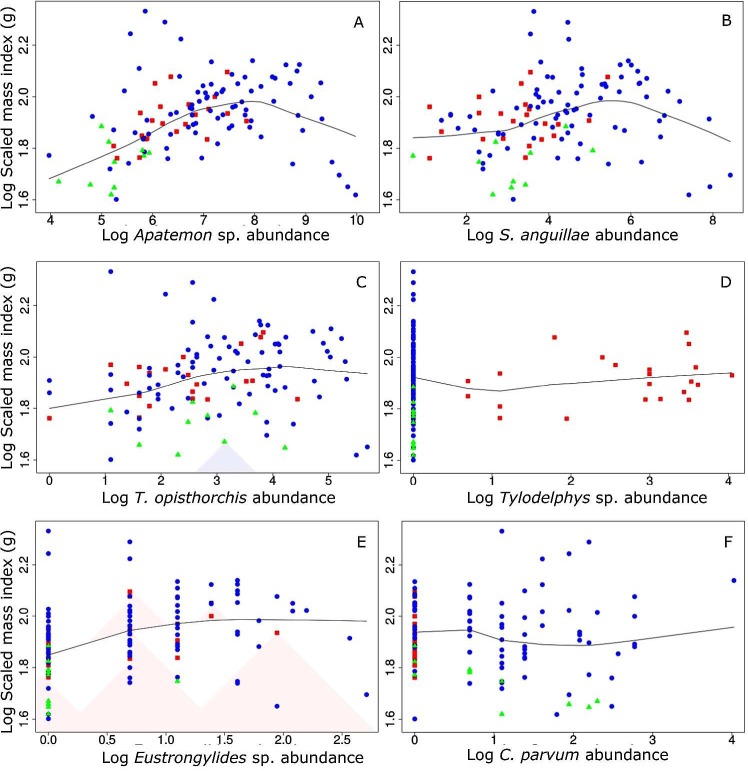
Relationships between scaled mass index (SMI, g) and abundances of the parasites Apatemon sp.(A), Stegodexamene anguillae (B), Telogaster opisthorchis (C), Tylodelphys sp. (D), Eustrongylides sp. (E) and Coitocaecum parvum (F) in common bullies (Gobiomorphus cotidianus) in lakes Hayes (red squares), Tomahawk (blue dots) and Waihola (green triangles). Lowess fitted curves are included on each graph.